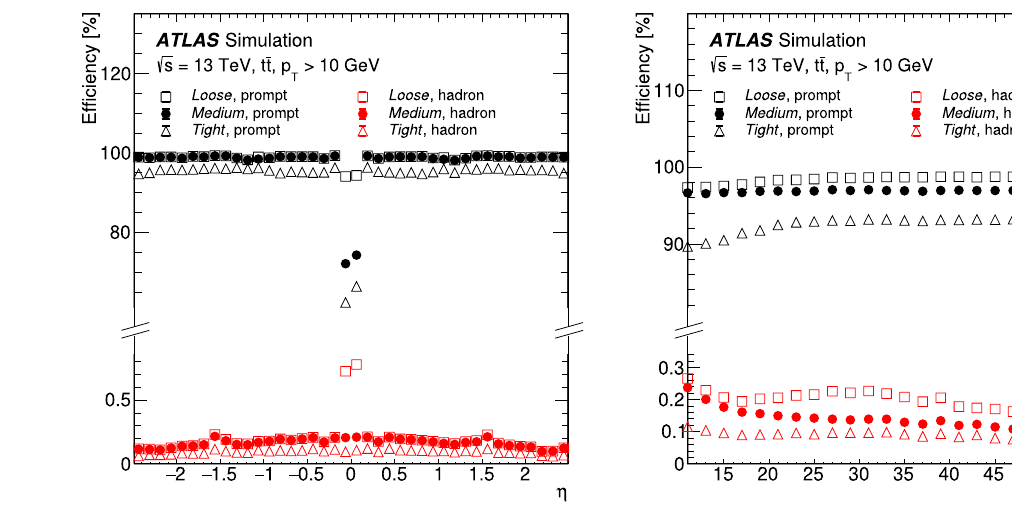
that are associated with a reconstructed muon passing the given WP requirements. The ID tracks are matched, respectively, to generator- level prompt muons or light